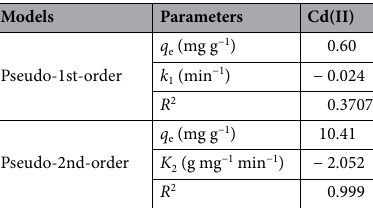
Table 4. Kinetic parameters for the adsorption of Pb(II) ions with Pip@MGO nanocomposite.